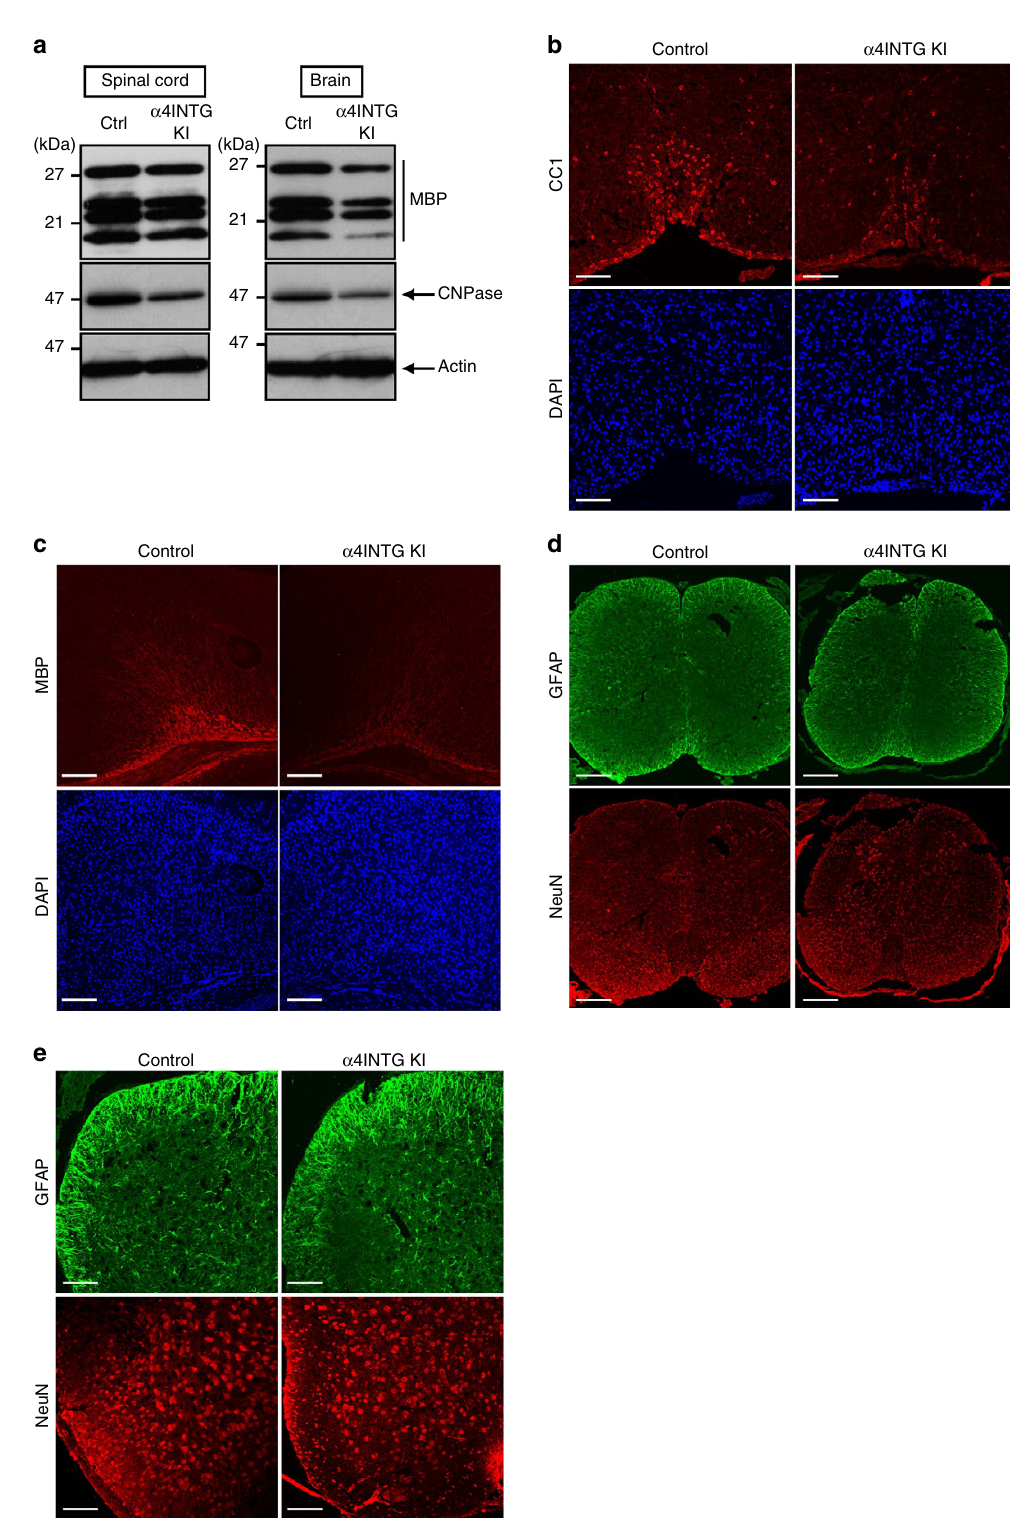
Figure 5 | Mutant mice of the VCAM1 ligand subunit a 4 integrin exhibit decreased myelin marker protein expression. ( a ) Tissue lysates from 7-day-old a 4 integrin knockin mouse ( a 4INTG KI) spinal cords or 11-day-old brains were immunoblotted with an antibody against MBP, CNPase or actin. Data are representative of two experiments. ( b ) In spinal cord cross sections at postnatal day 7, CC1 (red) and DAPI (blue) staining data are shown. Data are representative of two experiments. Scale bar, 100 m m. ( c ) Corpus callosum sections at postnatal day 11 were co-stained with an anti-MBP antibody (red) and DAPI (blue). Data are representative of two experiments. Scale bar, 200 m m. ( d , e ) Spinal cord cross sections at postnatal day 7 were stained with an antibody against GFAP (green) or NeuN (red). Data are representative of two experiments. Scale bar, 200 m m ( d ) or 100 m m ( e